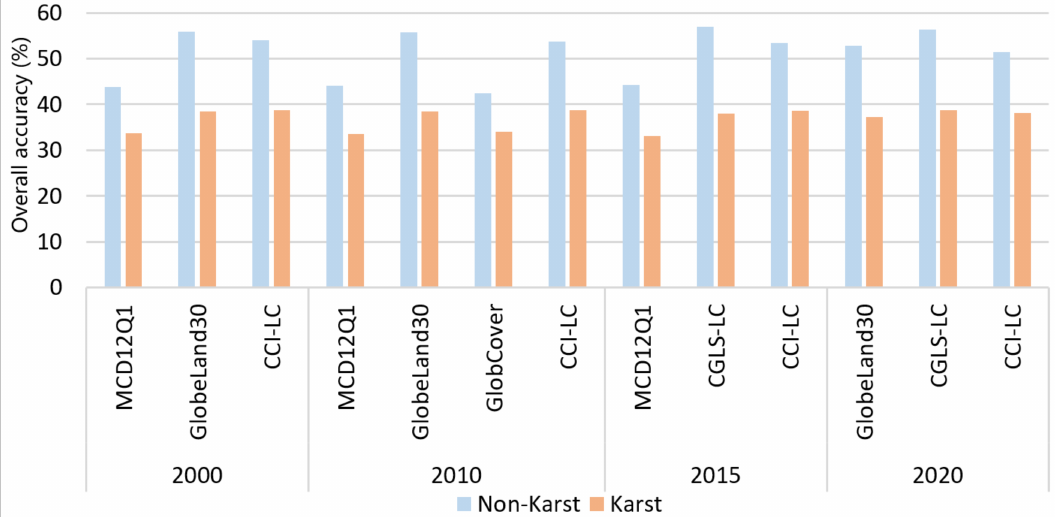
Figure 11. Overall accuracy of various LC datasets in karst and non-karst areas during the four